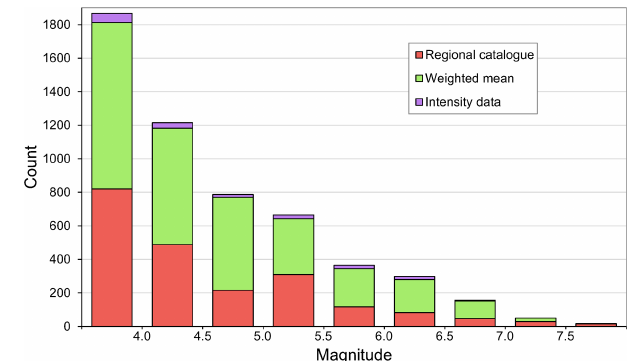
Figure 6. Percentages of the different types of magnitudes in EPICA, i.e. reassessed from intensity data, reassessed from a re- gional parametric catalogue, or the weighted mean of the two re- assessments; “Not determined” means that the available data do not allow a robust estimate.